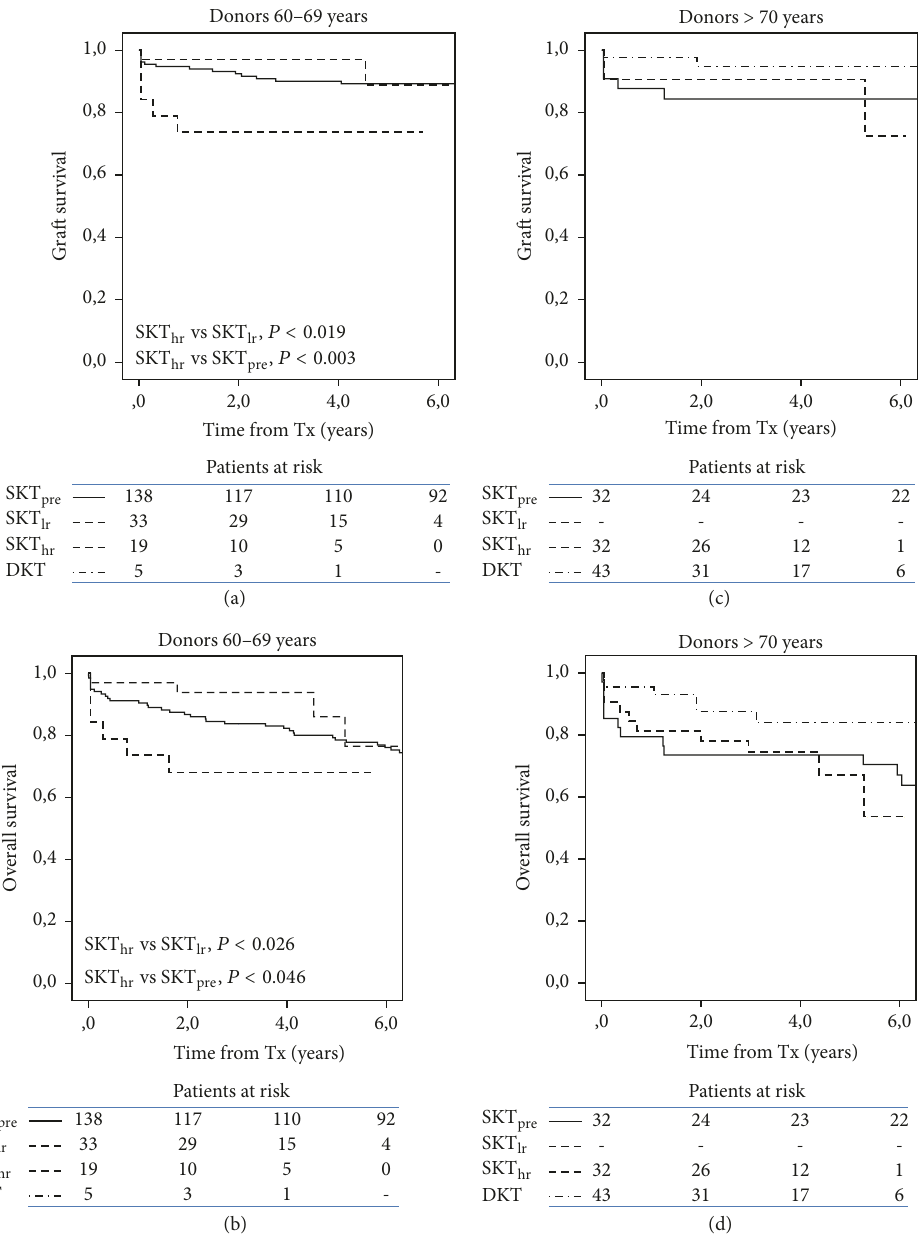
Figure 5: Kaplan-Meier plots of graft (a, c) and overall survival (b, d) in recipients by donor age and transplant category. Only in transplants from donors aged 60–69 years are graft and overall survival lower in SKT